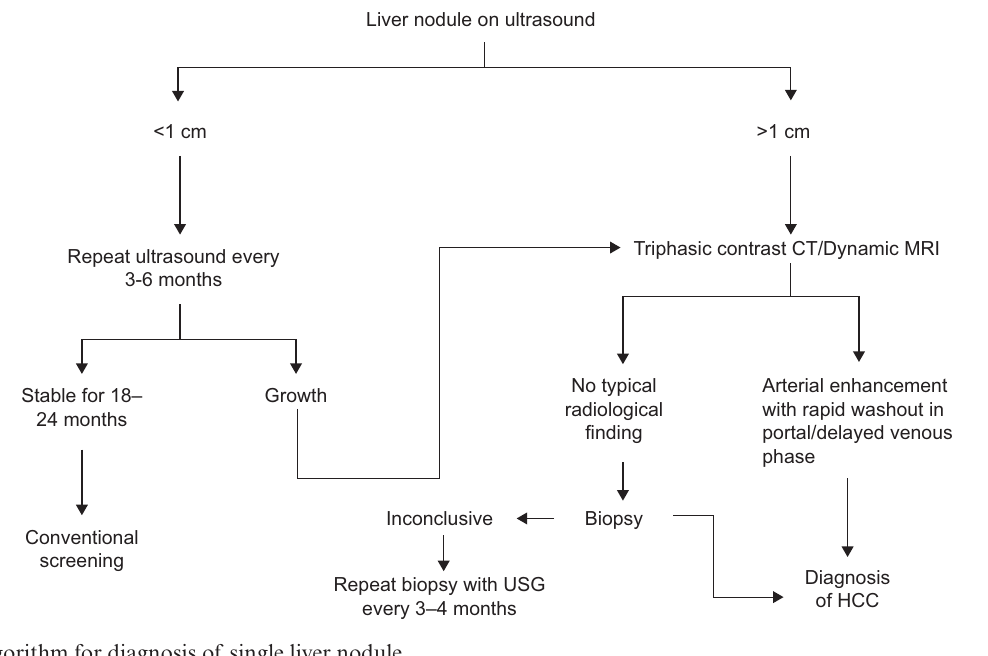
Figure 2: Algorithm for diagnosis of single liver